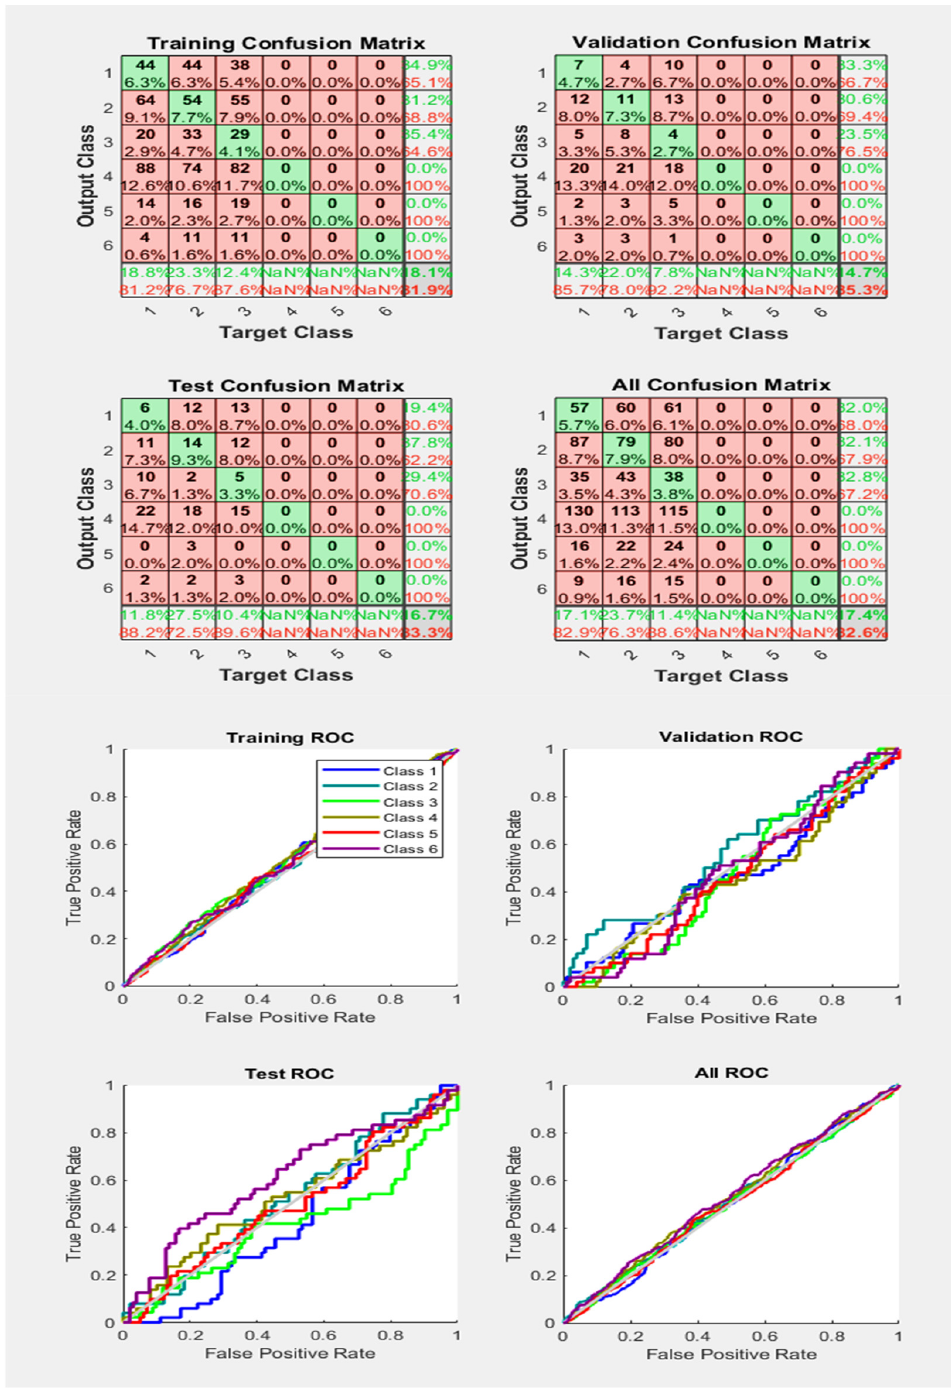
Figure 15. Neural Network Model ROC (Receiver Operating Characteristics) and Confusion Matrix for OSS TrainFcn/Activation Function at level 9 (RMS) Features for High Contact Resistance Fault with 82.6% Accuracy. Grey line shows diagonal of the ROC for indicating Class 1–6 lines are lying above or below or on it.